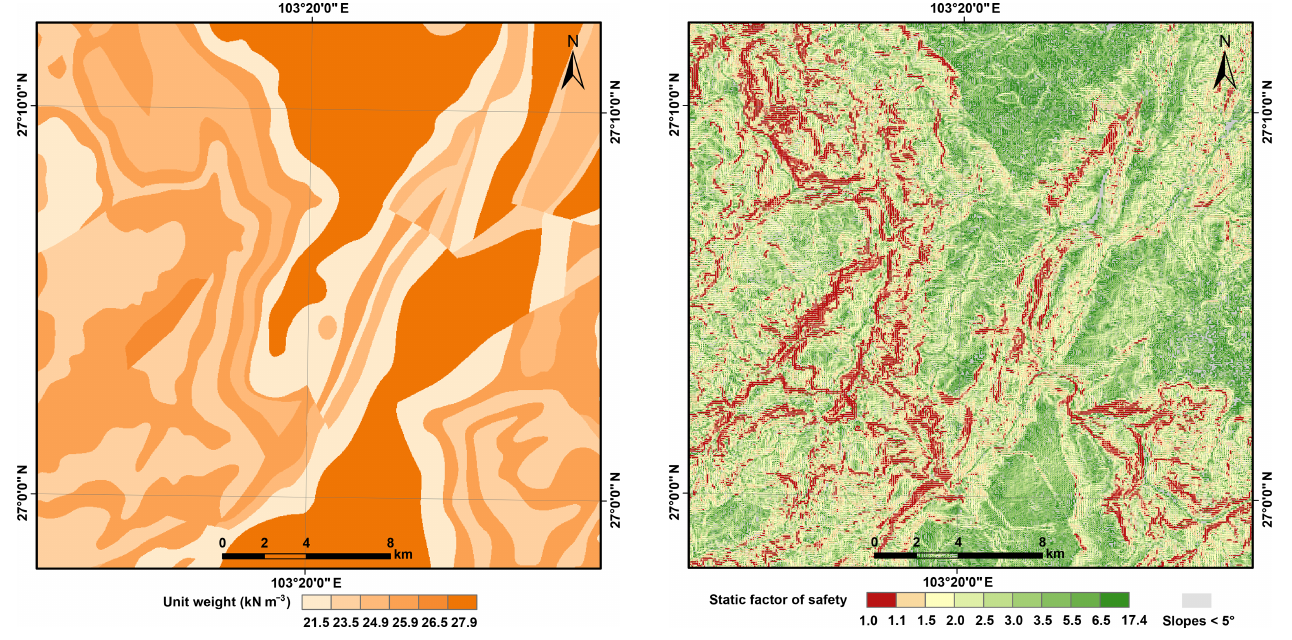
Figure 11. Unit weight ( γ ) assigned to rock types in the study area. Figure 12. Static factor-of-safety map of the study